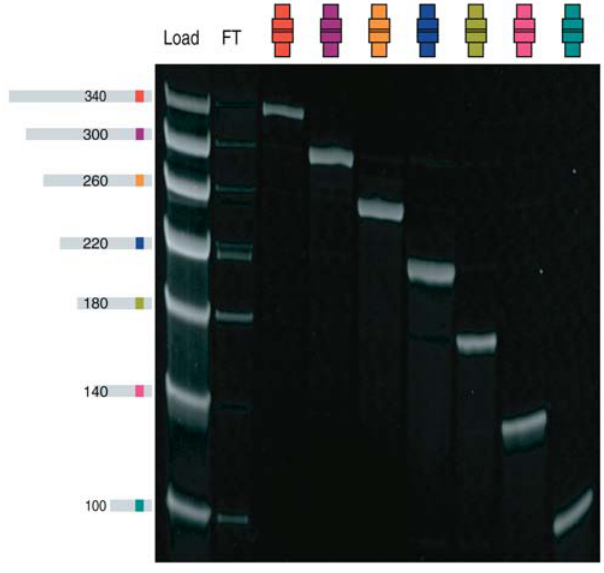
Figure 4. Sequence-Directed Splitting Seven serially truncated ssDNAs differing in sequence at one coding position (illustrated at left of gel, number of bases indicated) were hybridized to seven anticodon columns (cylinders at top of gel). The load (lane 1), flow through (lane 2), and column elutes (lanes 3–9) were analyzed by denaturing polyacrylamide gel electrophoresis. DOI: